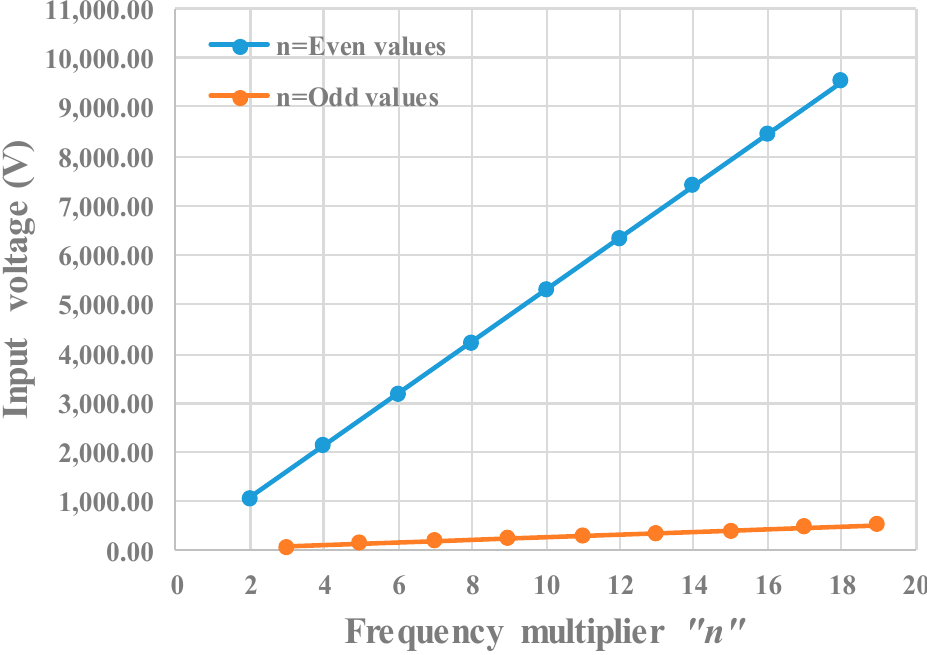
Figure 15. Input supply voltage ( V DC ) required for different values of the frequency multiplier “ n ” with the same output power ( P o = 30 W).